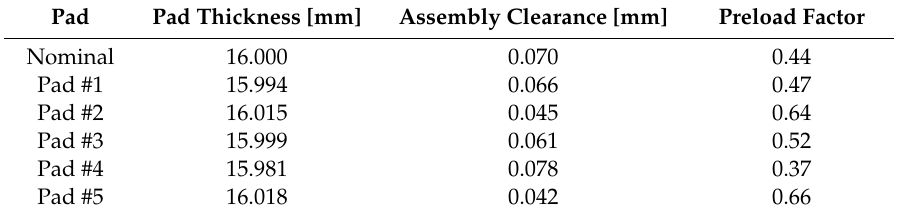
Table 4. Pad thickness, bearing assembly clearance and preload factor of the bearing under test